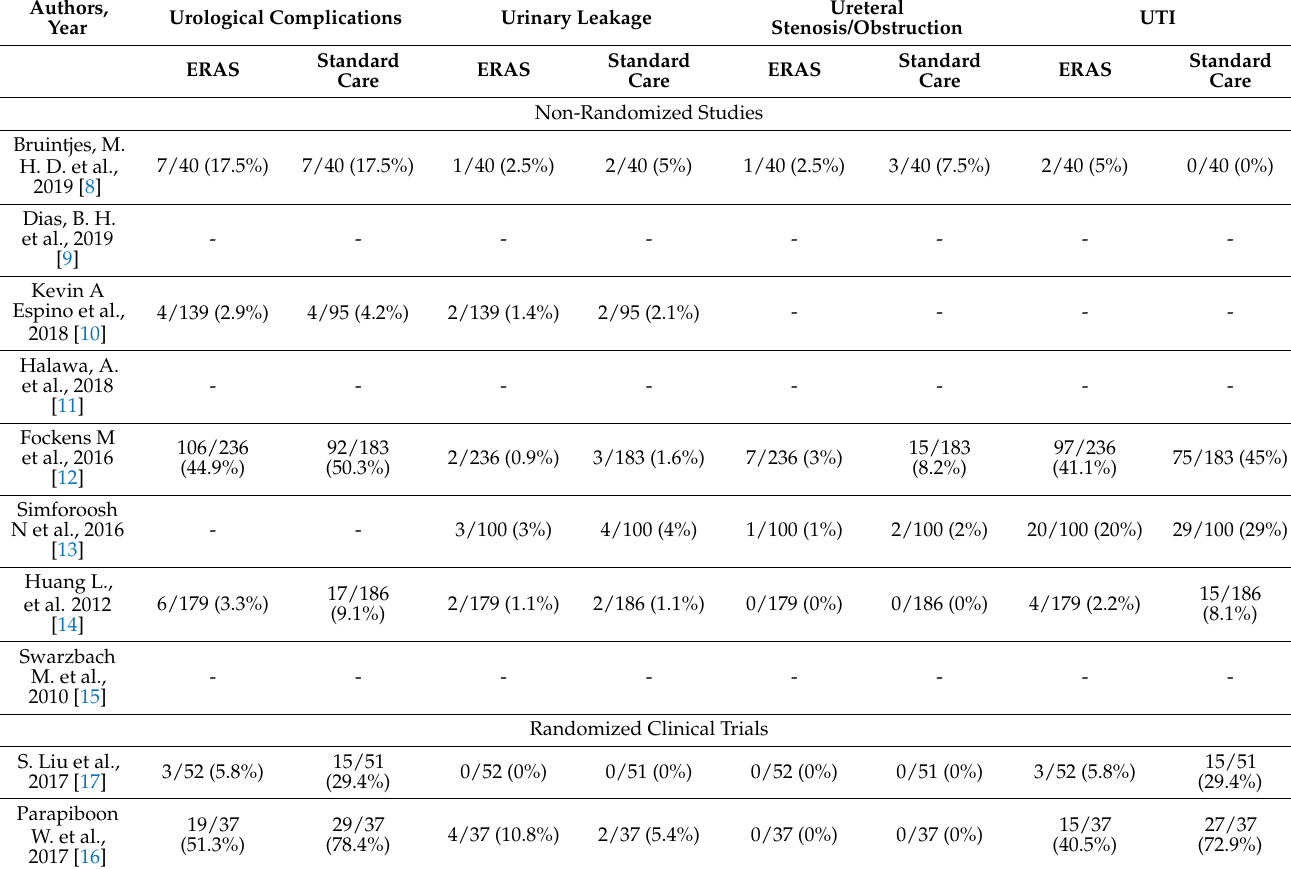
Table 7. Recipients’ urological